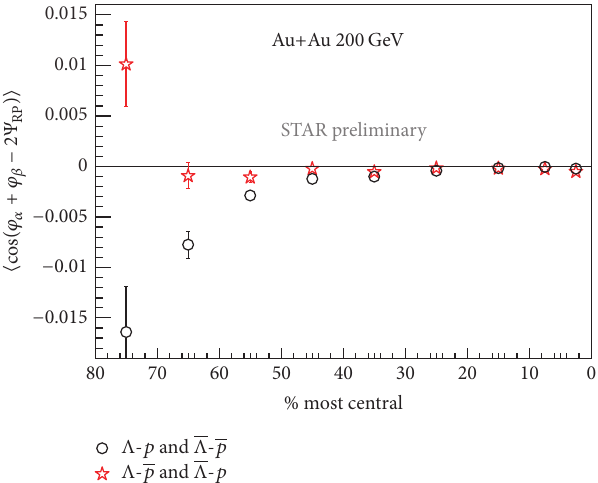
Figure 12: 𝛾 correlations of Λ - ℎ + ( Λ - ℎ − ) and Λ - ℎ − ( Λ - ℎ + ) as functions of centrality in Au+Au collisions at 200 GeV [62].